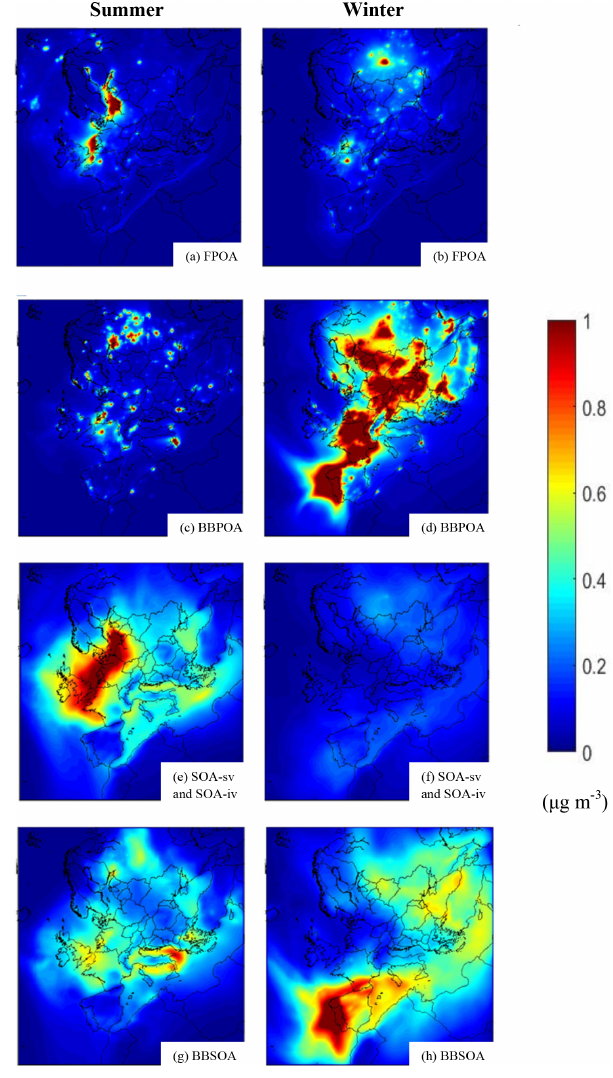
Figure 4. PMCAMx-SR predicted base case ground-level